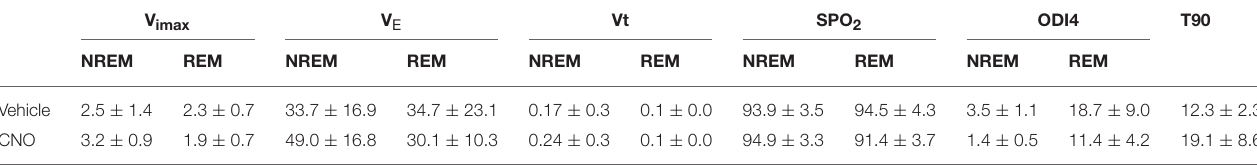
Vimax, maximal inspiratory flow; V E , minute ventilation; Vt,tidal volume; SpO 2 ,mean oxyhemoglobin saturation; ODI4,oxygen desaturation index ( ≥ 4%frombaseline) per hour ofsleep; T90, the percentage of total sleep time spent with SpO 2 < 90%. Values are presented as means ± SEM.